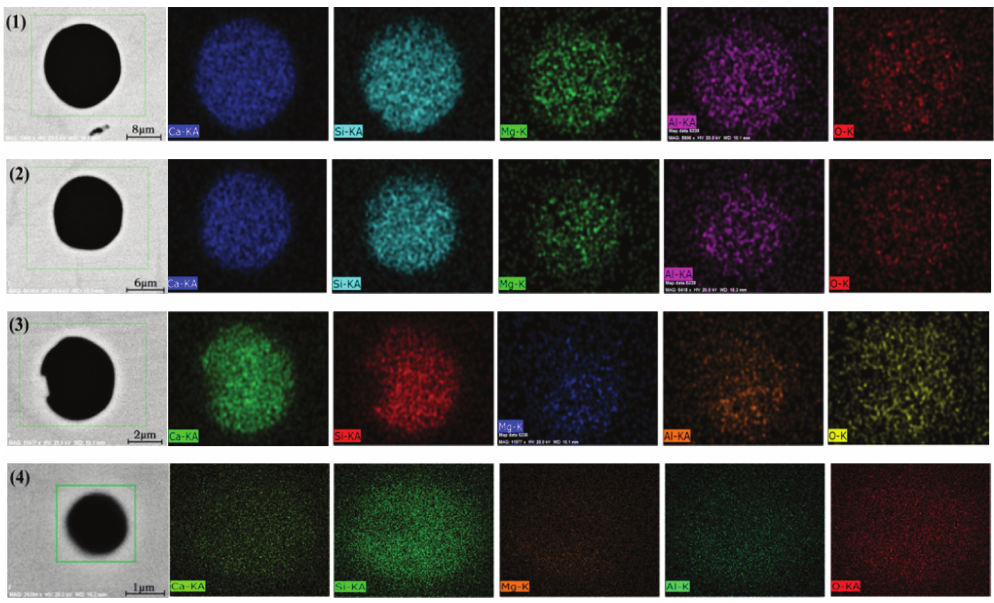
Figure 2: Distribution of main elements in different